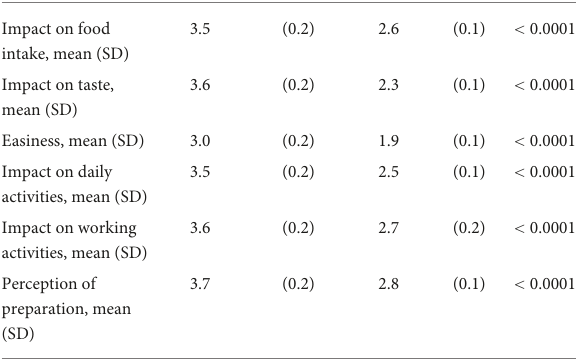
TABLE 3 Impact of bowel preparation on patients’ acceptance